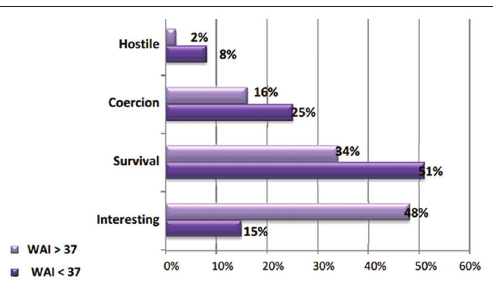
FIGURE 4. Work ability and absenteeism distribution in last 12 months. The sick leave was not used by 118 (59%) employees with good work ability. Among 13 (18%) employees with bad work ability, 6 (8%) of them used sick leave for 61-90 days and 5 (7%) used the leave for 100-365 days in last 12 months. Long-term absenteeism was not reported by the employees with good work ability.